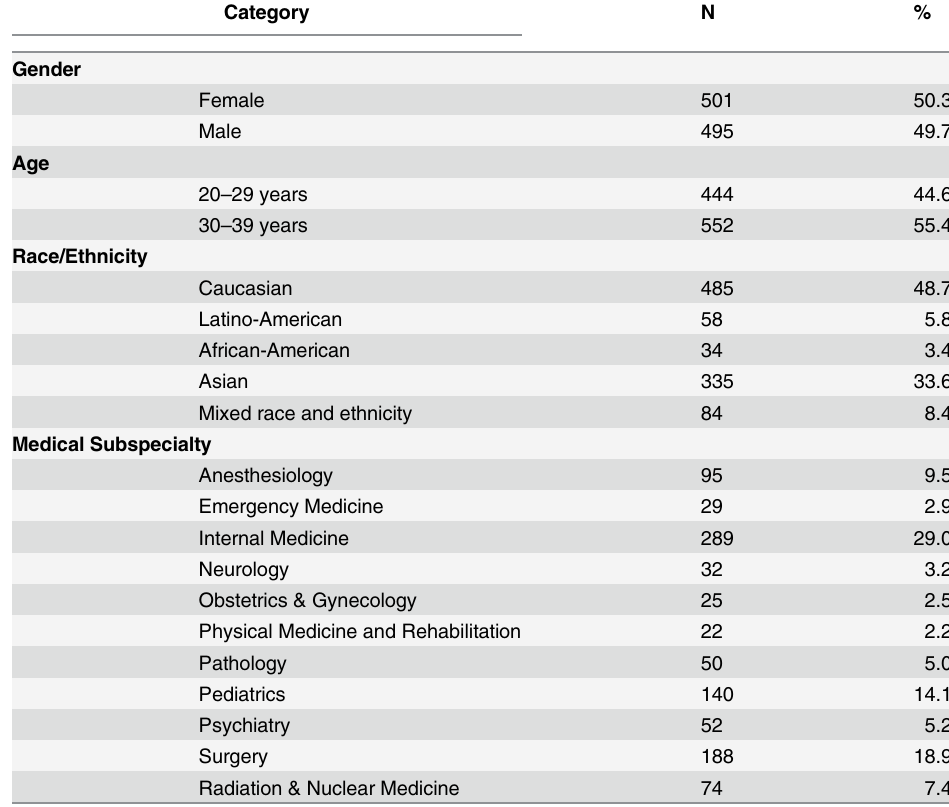
Table 2. Demographic characteristics showing validation cohort participant gender, age, race, ethnic- ity and subspecialty (n = 996). Category N %